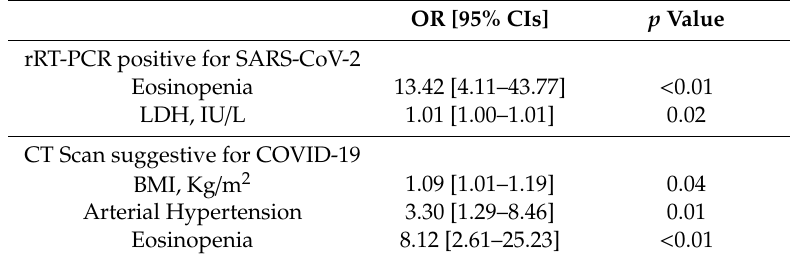
Table 3. Multivariable logistic regression to predict rRT-PCR positive or suggestive chest